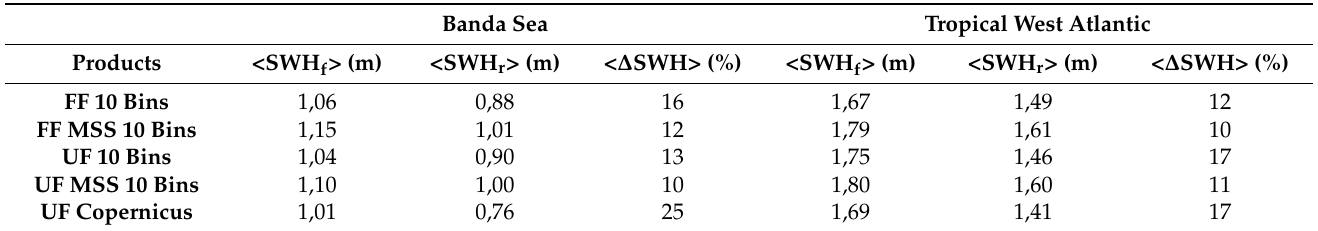
Figure 5. Bar plots representing average significant wave heights (SWHs) for leading (i.e., front) and trailing (i.e., rear) sections (see text for details) of the ISWs for all cases in Table 1. Table 2. Mean of SWHs in front and rear of ISWs (see text for details) and differences between both (in percentage) for cases in the Banda Sea and Tropical West Atlantic. In light orange colors (bottom row), the same method is used for all Copernicus UFSAR cases (which are not exactly the same as those considered in gray shaded rows, see text for more